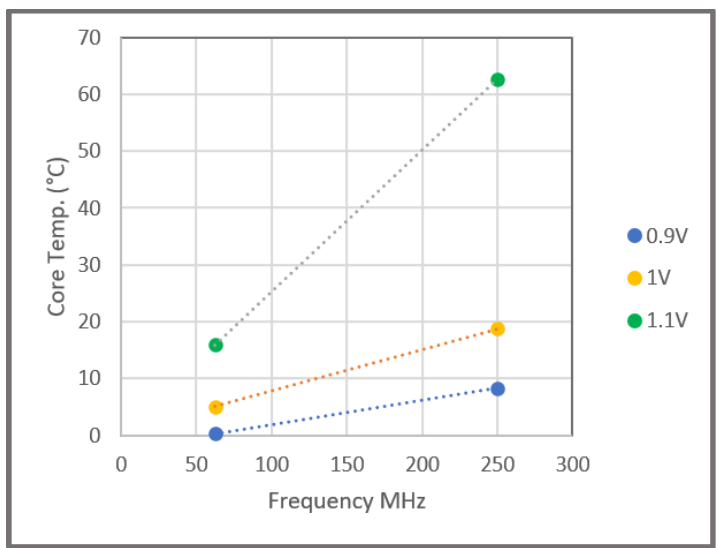
Figure 4. Temperature offset of the chip using open inverter chains. The results include three different core voltages: 0.9 V, 1 V, and 1.1 V.